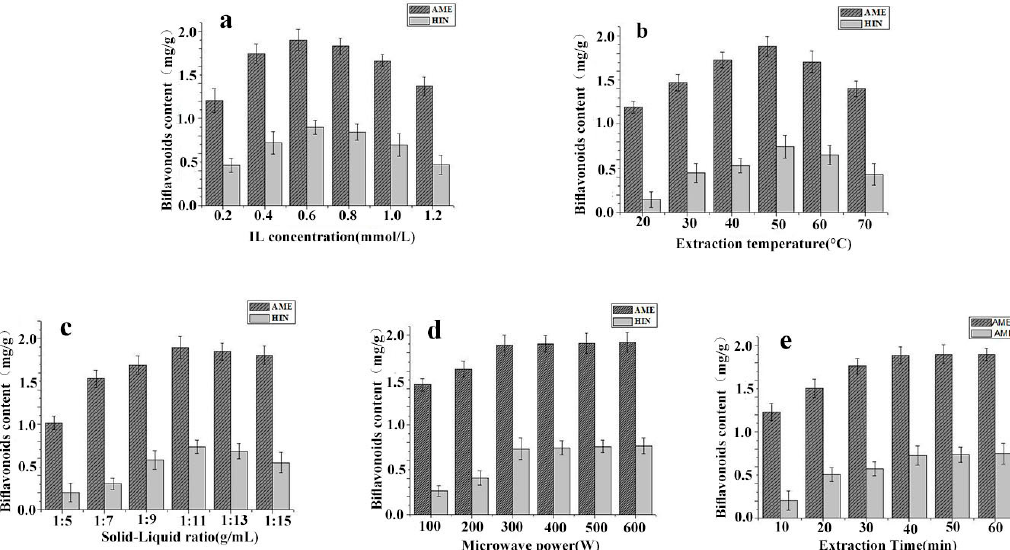
Figure 3. Effects of extraction parameters on two biflavanoids yields of S. sinensis . ( a ) IL concentration; ( b ) extraction temperature; ( c ) ratio of solid to liquid; ( d ) microwave power; ( e ) extraction time.